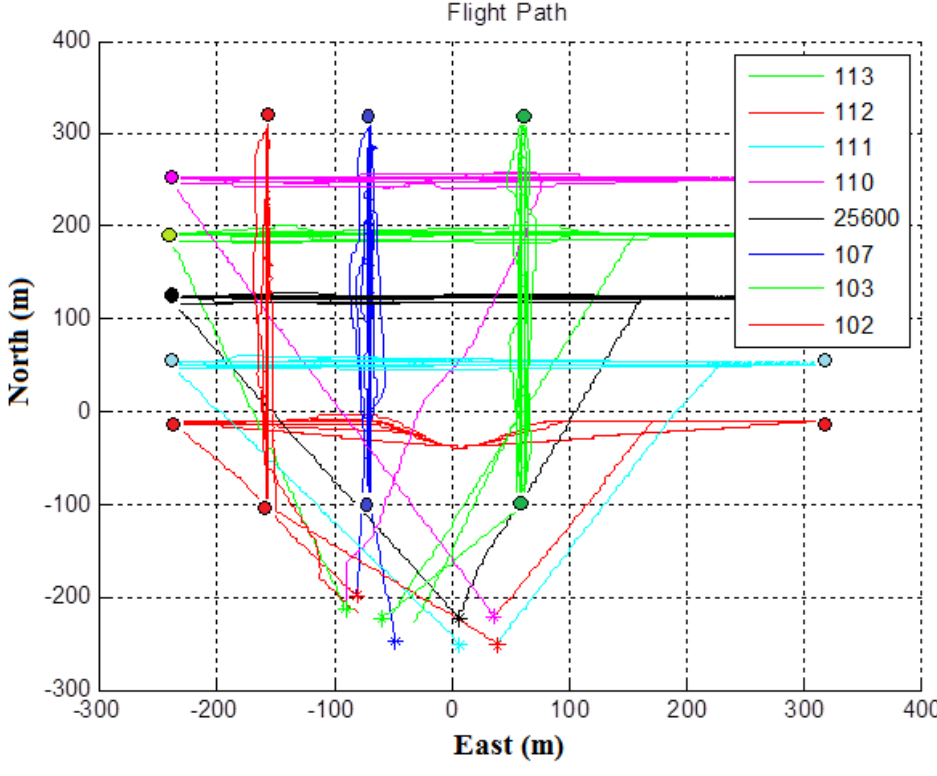
Figure 23. HILS: Patrol motion control of eight UAVs: stars represent launching points and recovery points, circles represent target waypoints.